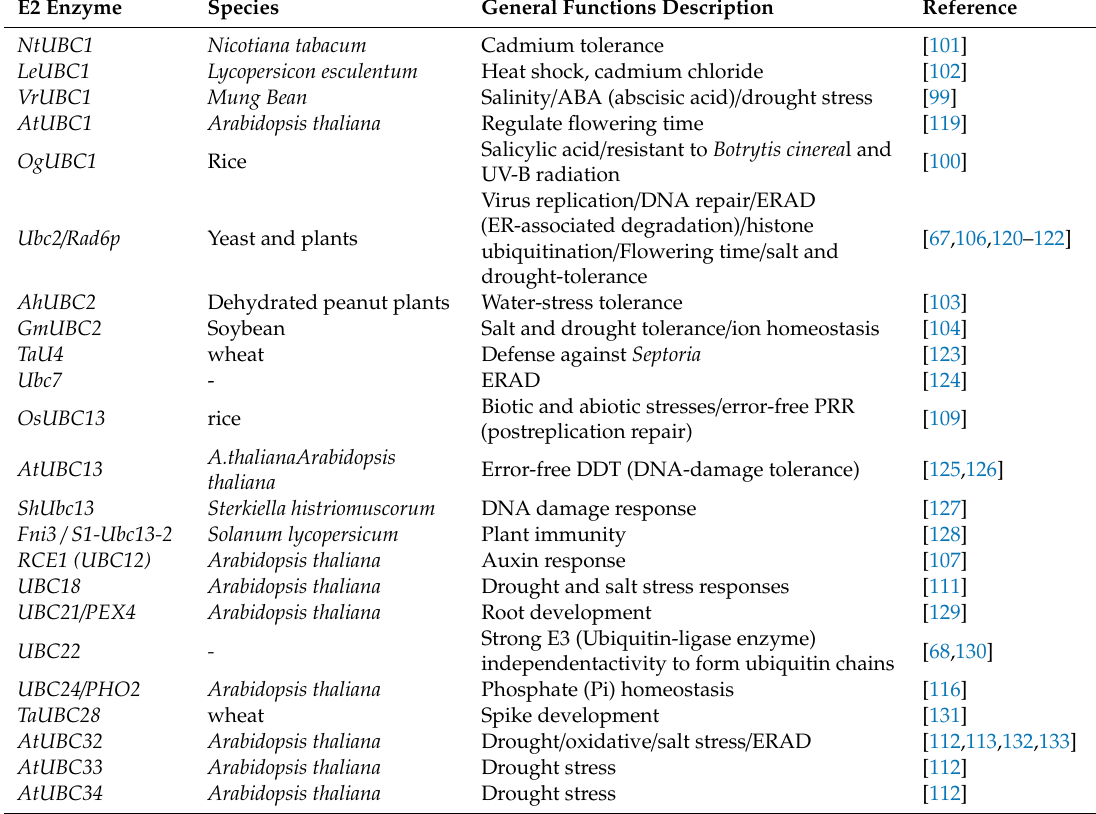
Table 1. Ubiquitin-conjugating enzymes with di ff erent known functions a